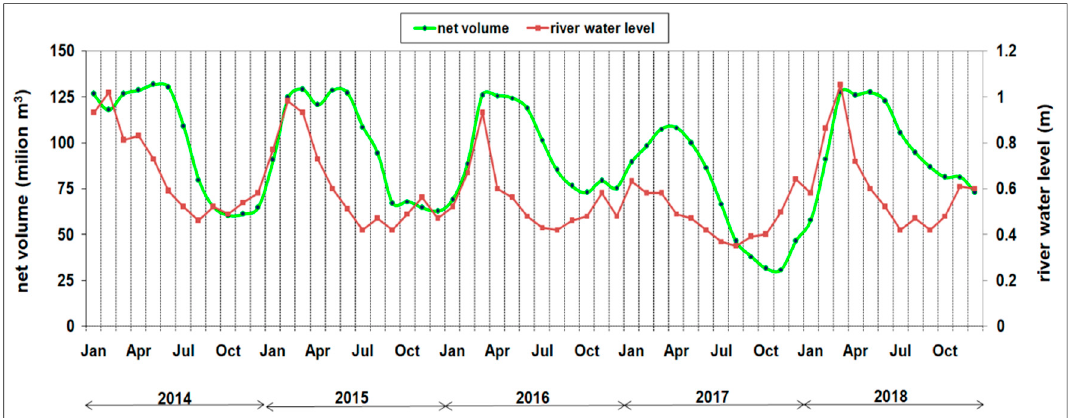
Figure 2. Monthly averaged net volume of PL (green line) and water levels measured at the Grumento—Ponte La Marmora station (red line) for the investigated 2014–2018 period.